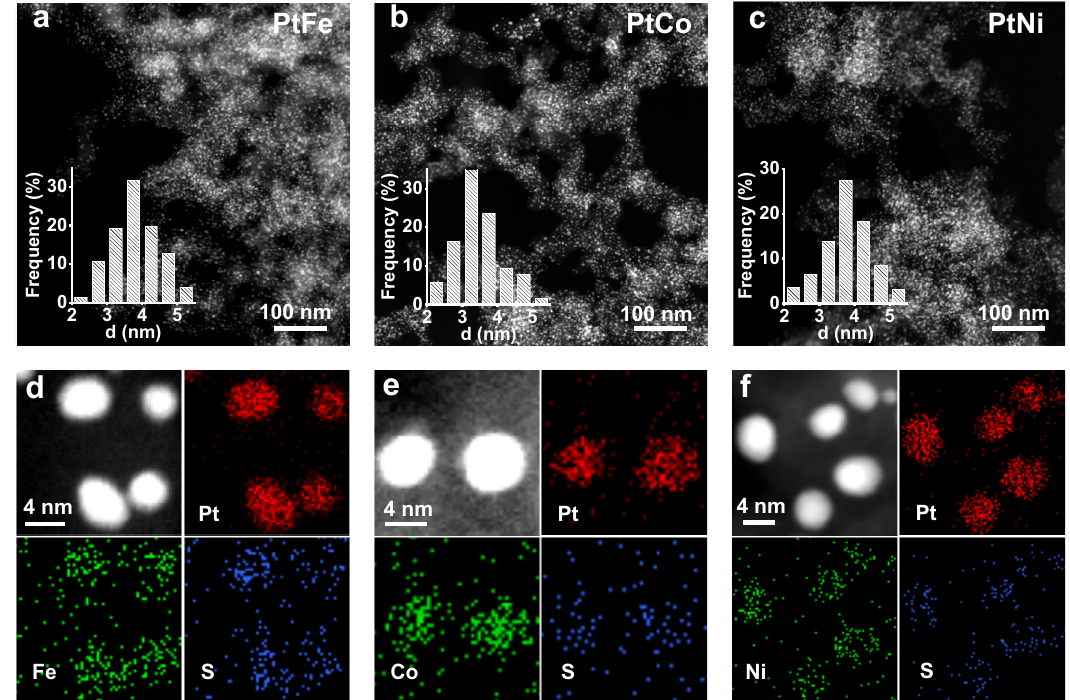
Fig. 3 | Structural characterization of the Pt-IMCs catalysts. HAADF-STEM ima- ges of PtFe ( a ), PtCo ( b ), and PtNi ( c ) prepared with STG. Inserts were the